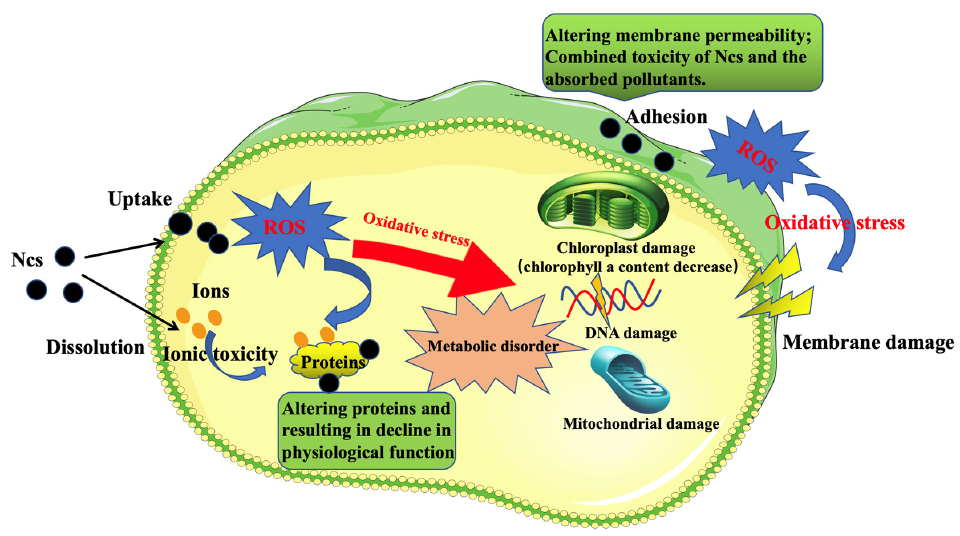
Figure 3. Proposed interactions of Ncs with aquatic organisms at the cellular level. Direct penetration and dissolution are two pathways for Ncs internalization by cells. The internalized Ncs can cause oxidative stress, mitochondrial dysfunction, and DNA damage. Adhesive Ncs in the membrane can adsorb contaminants in the aquatic environment and change the membrane permeability.